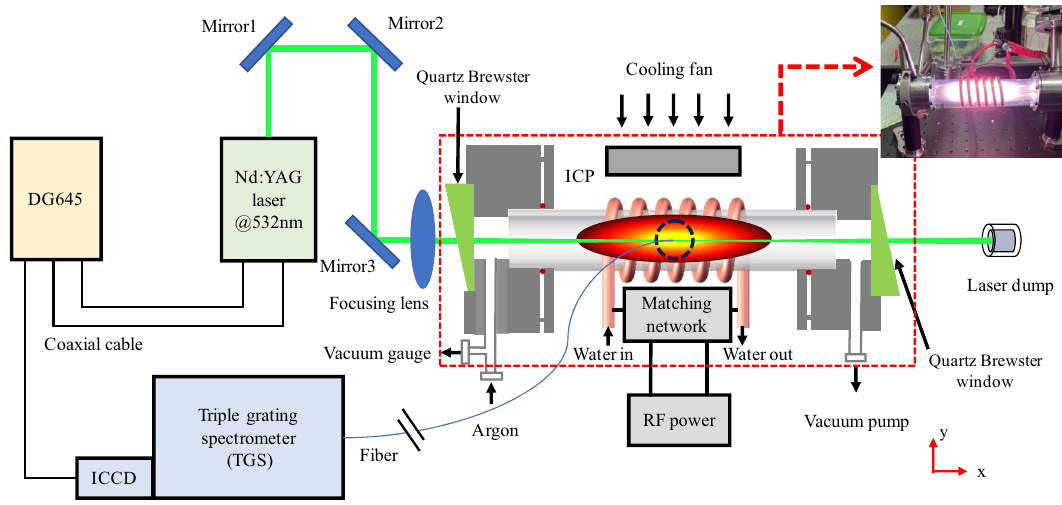
Figure 1. Schematic diagram of the TS experiment. In the upper right corner is a photo of the ICP generator corresponding to the red box in the schematic.